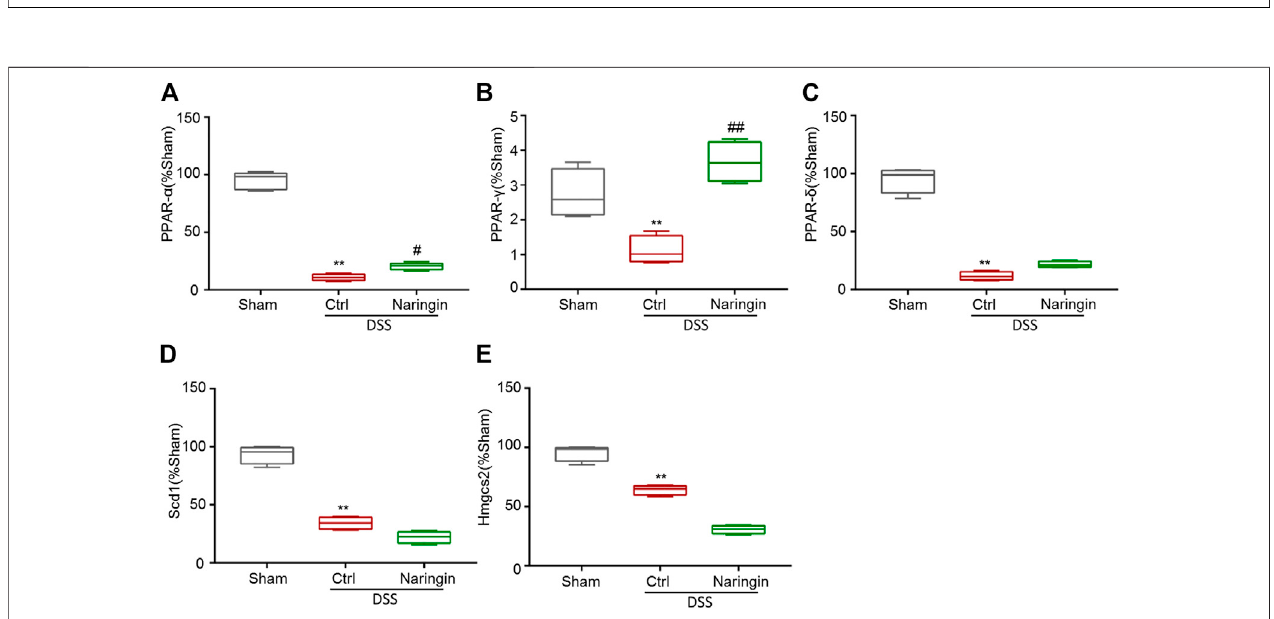
FIGURE 6 | The effect of naringin on some mRNAs in PPAR signaling pathways detected by qRT-PCR. Naringin (40 mg/kg) was administered to mice by gavage once a day for seven consecutive days. The expression levels of some mRNAs in PPAR signaling pathways including (A) PPAR- α , (B) PPAR- γ , (C) PPAR- δ , (D) Scd1, and (E) Hmgcs2 were detected by qRT-PCR (means ± SD, n (cid:2) 3). ** p < 0.01 compared with sham group; # p < 0.05, ## p < 0.01 compared with DSS-colitis group.